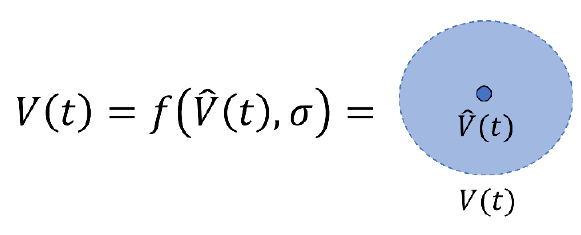
Figure 2 . We propose that operator growth of V ( t ) can be described in terms of a bare operator ^ V ( t ) surrounded by an expanding hydrodynamic cloud.